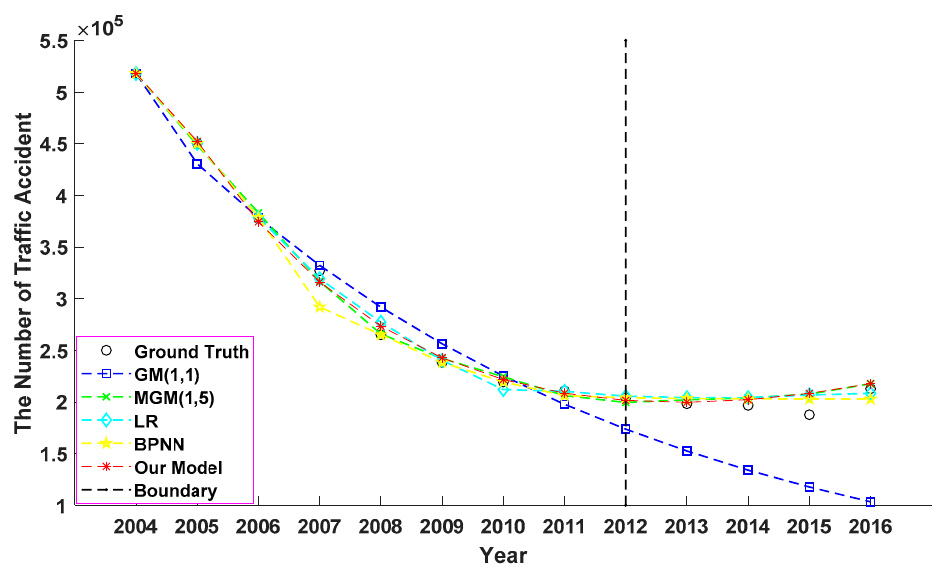
Figure 4. Result of trend prediction for the country of China.